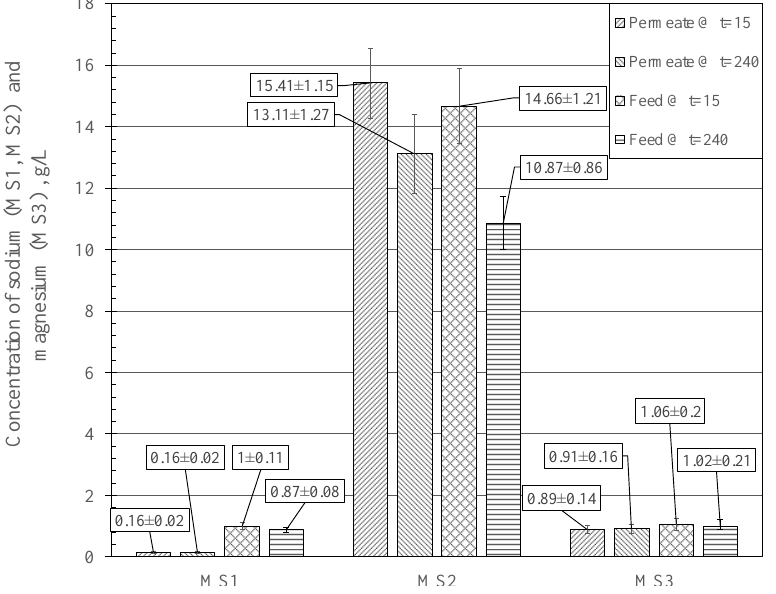
Figure 4. Concentration of sodium and magnesium cations in permeate and feed sides after 15 and 240 min of separation.